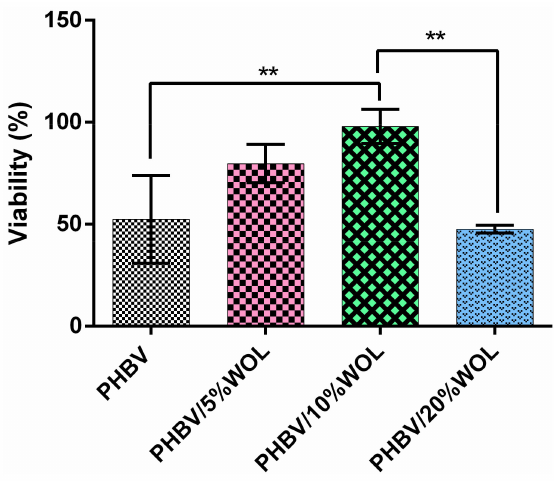
Figure 8. Human dental pulp stem cells proliferation on PHBV, PHBV / 5%WOL, PHBV / 10%WOL, and PHBV / 20WOL% films after 3 days. Results are given as mean ± SD (n = 3). One-way ANOVA, significance levels: ** p <